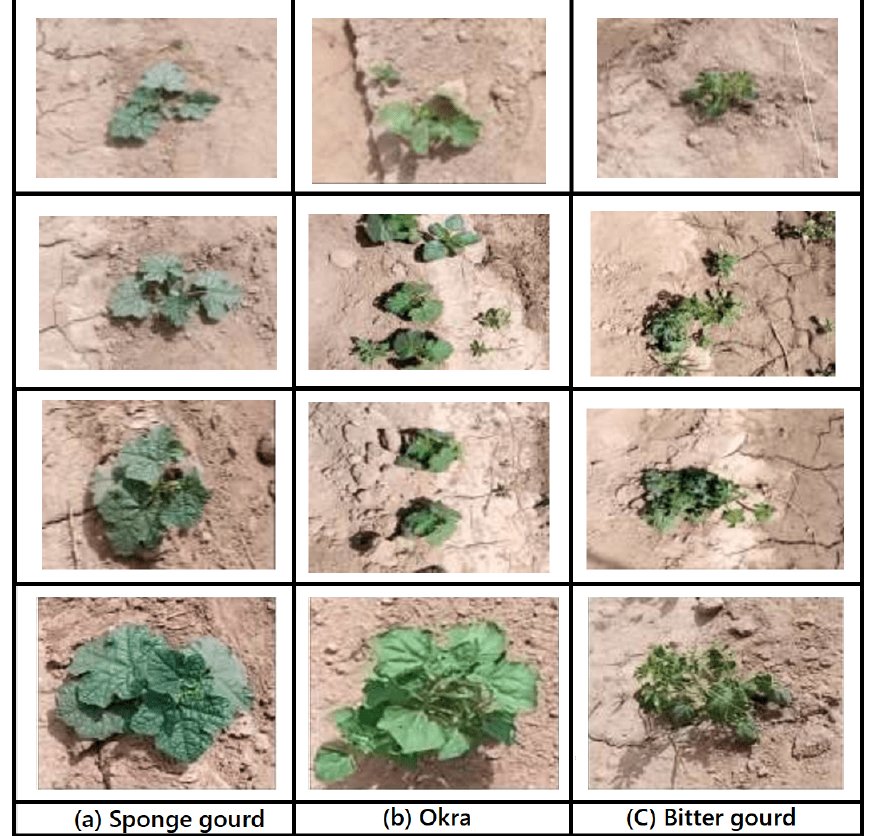
Figure 2. Visuals of various crops collected in the dataset. Each column contains different sample images of the crops in the collected data. Column ( a ) represents sponge gourd, ( b ) okra, and ( c ) bitter gourd, respectively.